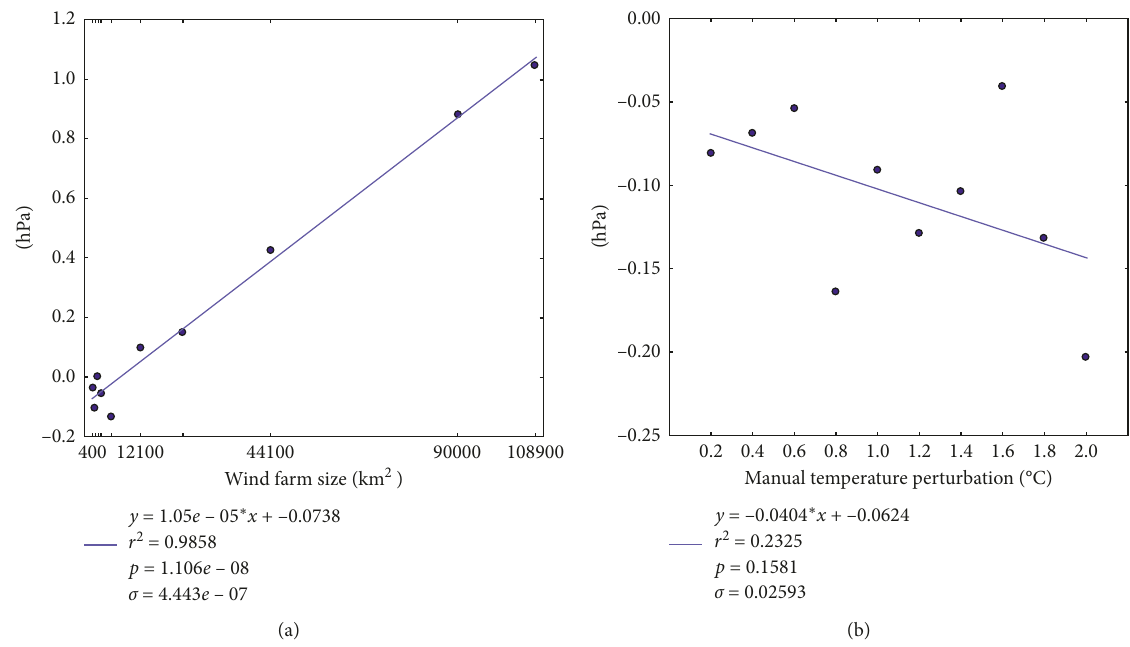
Figure 16: Largest perturbation of cyclone minimum sea-level pressure for the ten wind farm sizes (a) and unrealistic effects ensemble (b) for the 26 April 2014 midlatitude cyclone